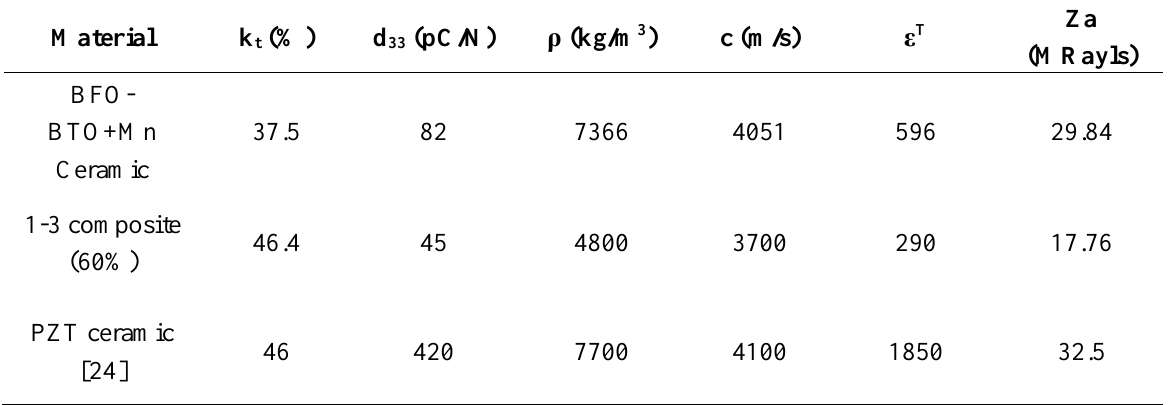
Table 1. Properties of the BFO-BTO+Mn ceramic, 1-3 composite and PZT